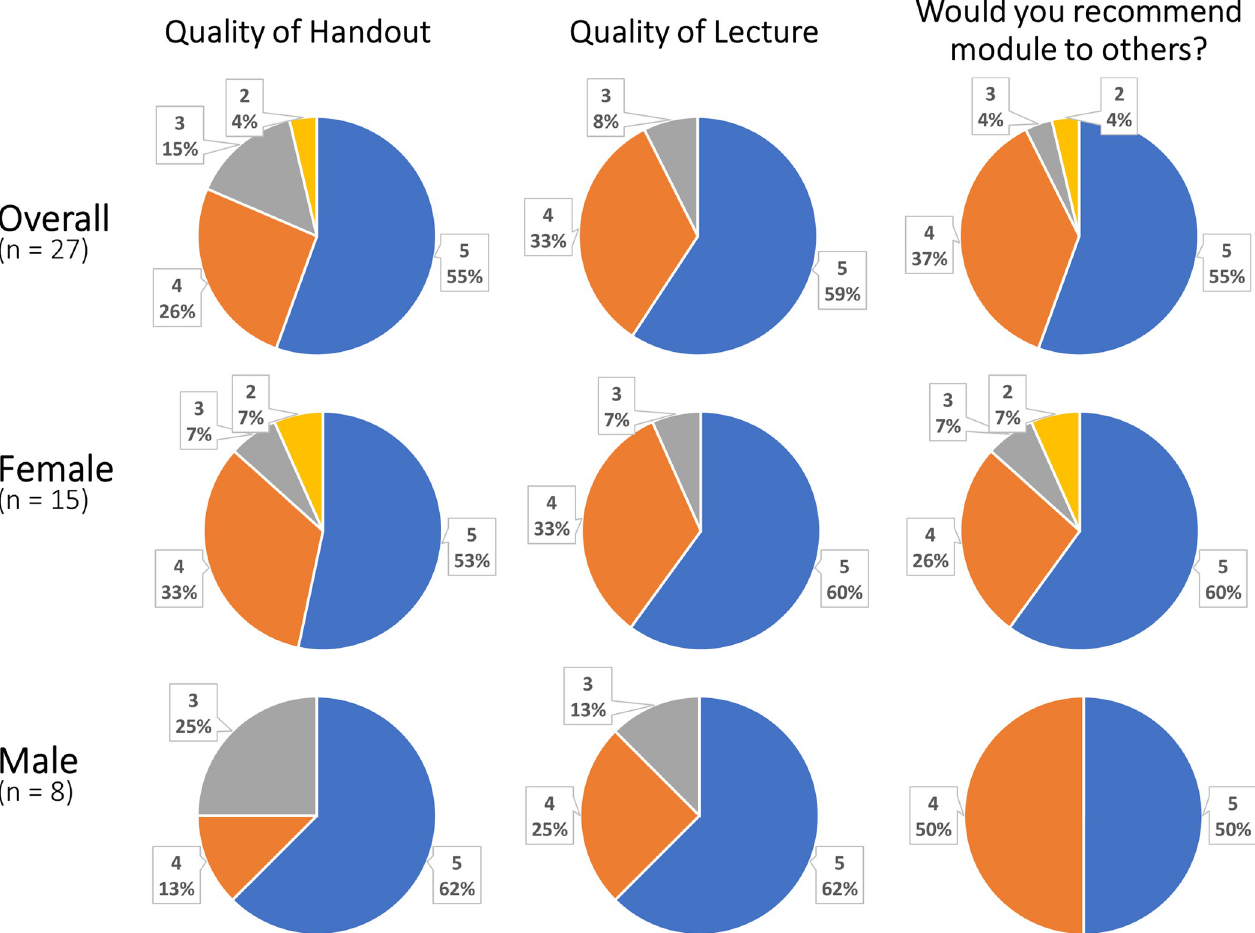
Fig 2. Participant rating of the components of the Future Life Map exercise. This shows the distribution of responses on 5-point Likert scales of the entire group, and separated by gender for those participants who identified a gender. Number indicates Likert score and percent corresponds to percent of respondents selecting that